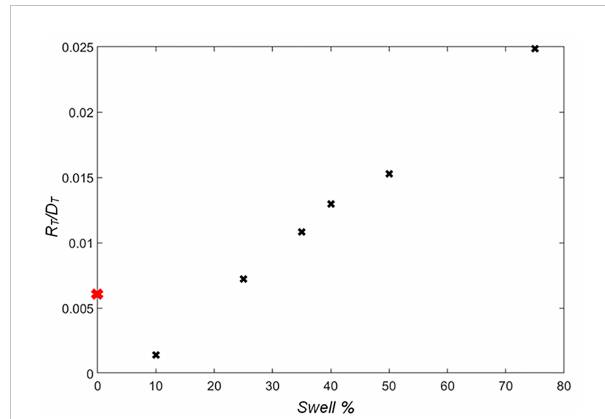
FIGURE 7 Swell percentage (Swell%) compared with the time duration that wave run-up equals maximum crest level (R T ) divided by total storm duration (D T ). Black cross represents bimodal conditions and red cross represents unimodal